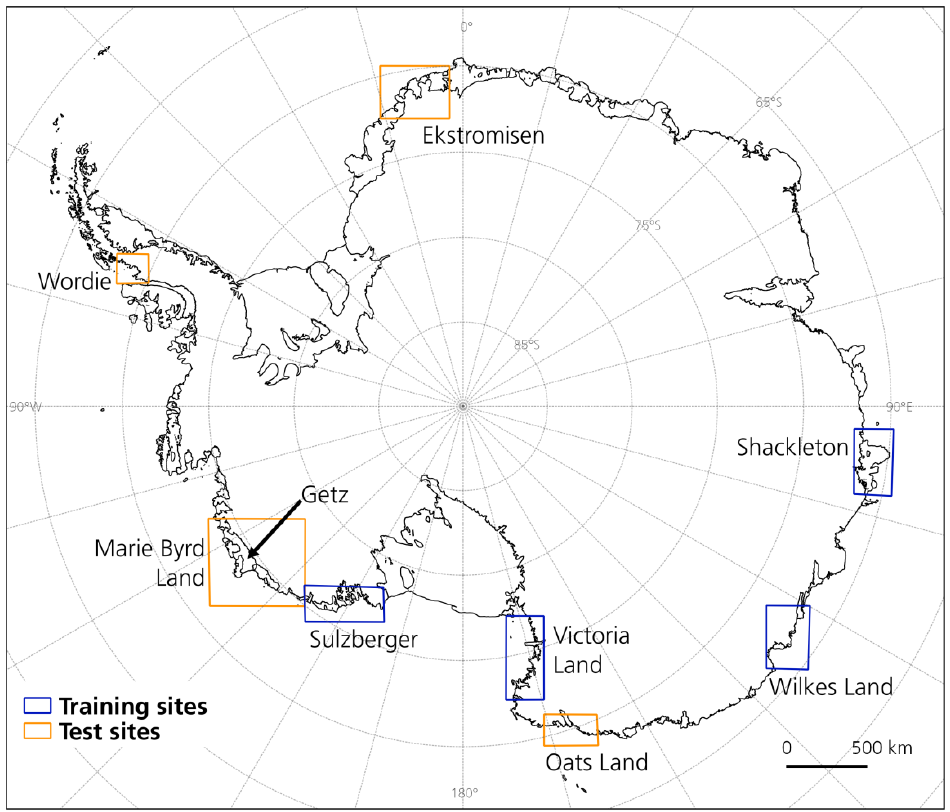
Figure 1. Training and test sites along the Antarctic Figure 1 Training and test sites along the Antarctic coastline.